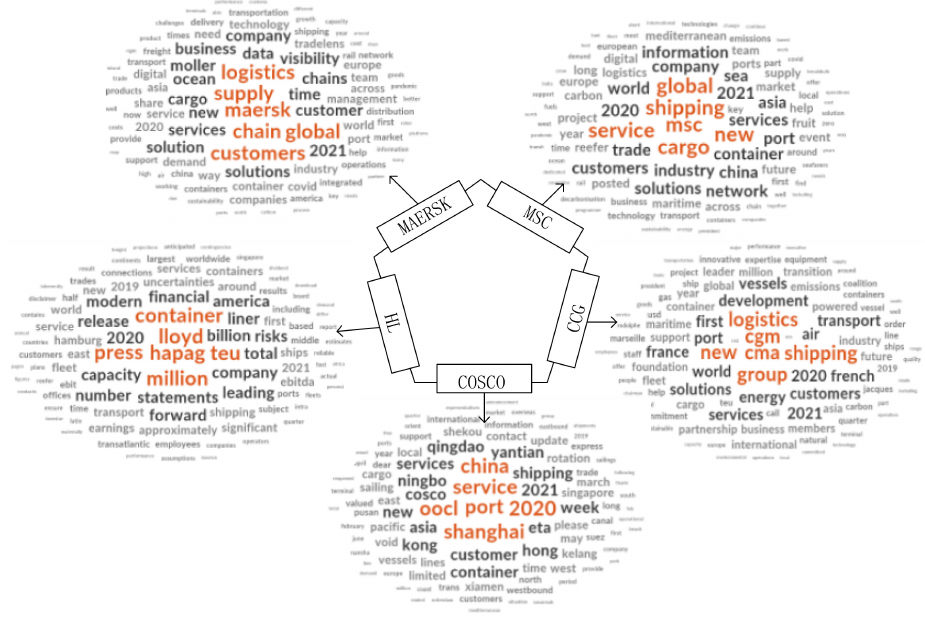
Figure 2. Word cloud of MAERSK, MSC, CCG, COSCO and HL.